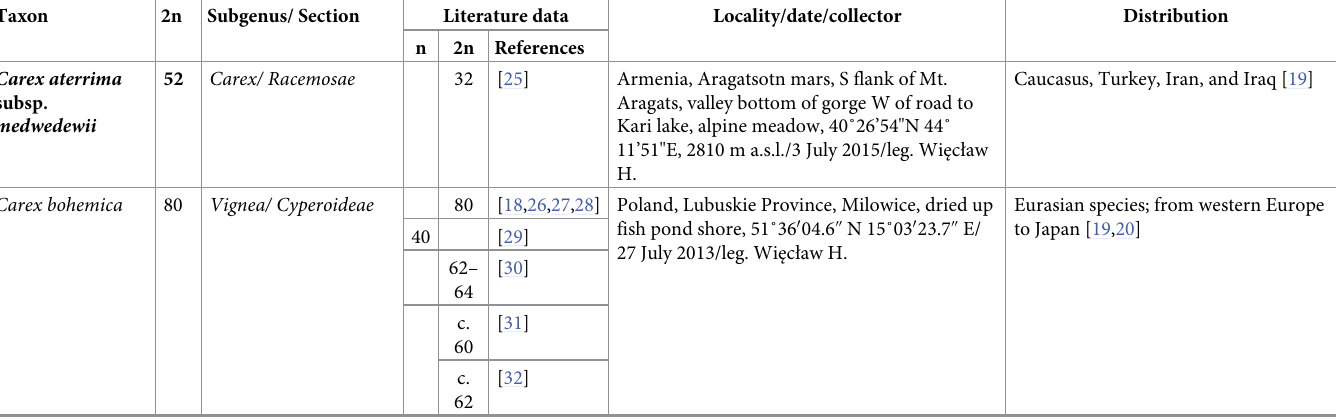
Table 1. Chromosome numbers of studied taxa against the background of available literature data. Taxa with chromosome numbers reported for the first time or with chromosome numbers significantly different from literature data are given in bold.